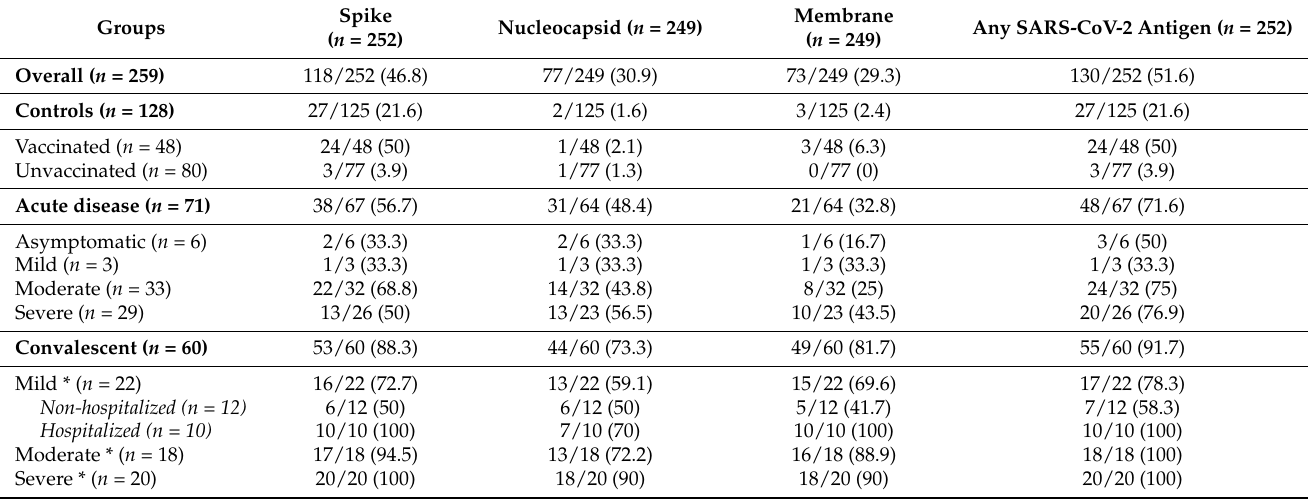
Table 2. Overall positivity results for the T-cell IFN- γ secretion against each antigen, including borderline results